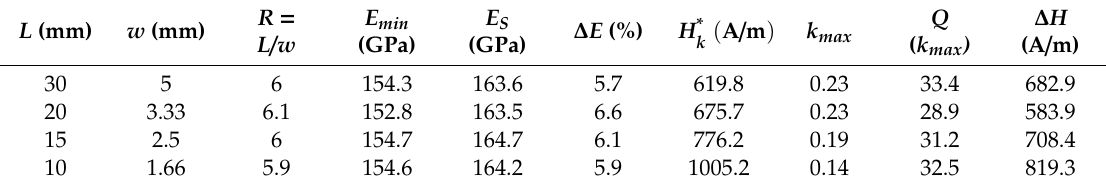
Table 2. Magnetoelastic characterization values obtained from the resonance / anti-resonance frequency measurements for strips with R = 6 equal or close value.